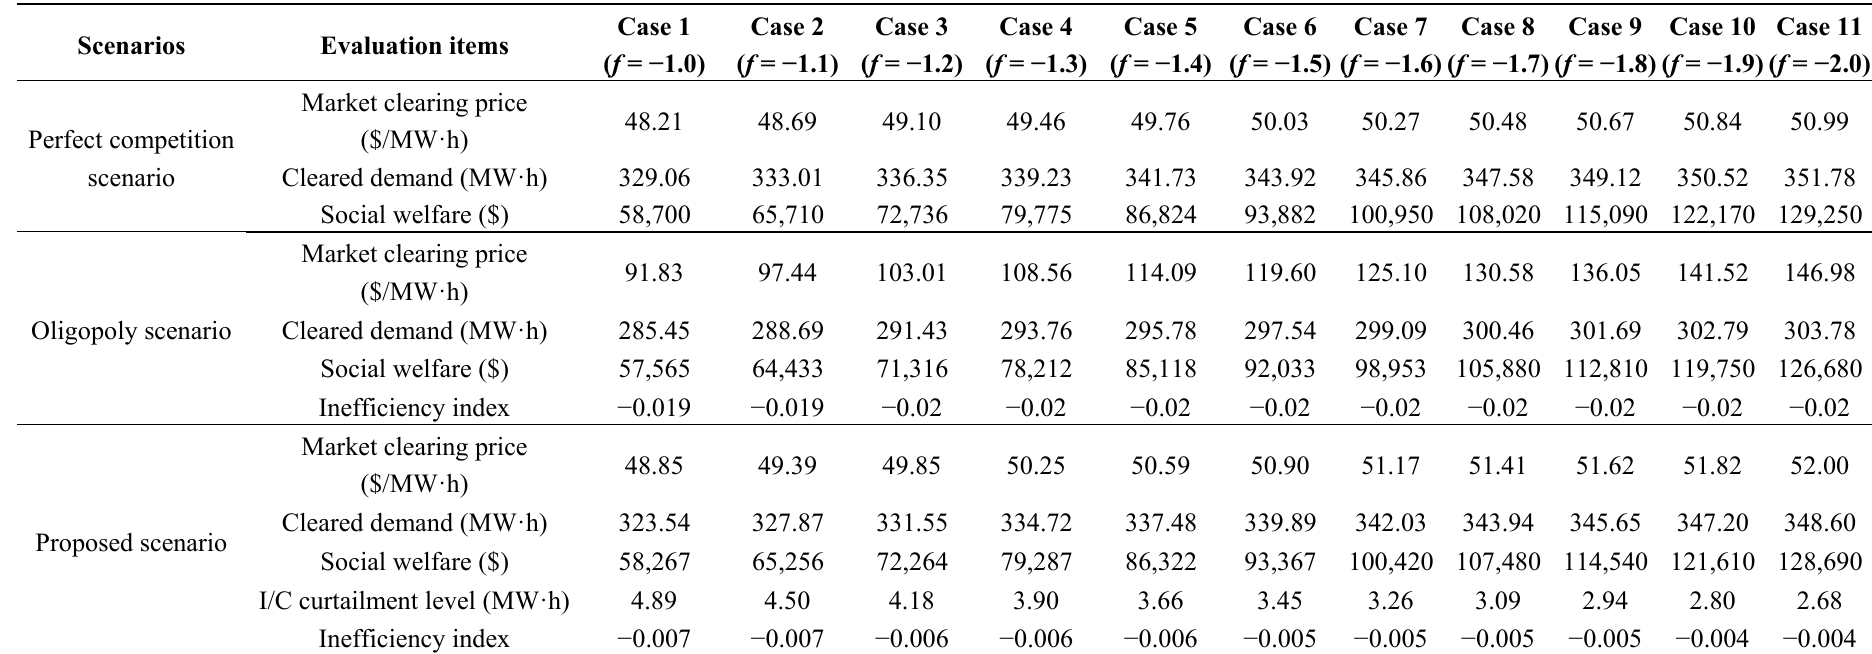
Table 2. Simulation results with respect to demand curve